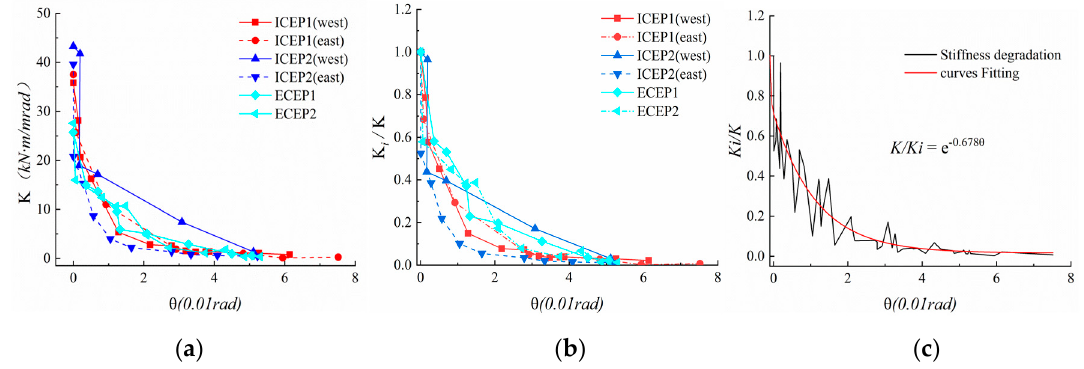
Figure 15. Stiffness degradation curves: ( a ) Stiffness value degradation; ( b ) Stiffness degradation ratio; ( c ) Stiffness degradation fitting